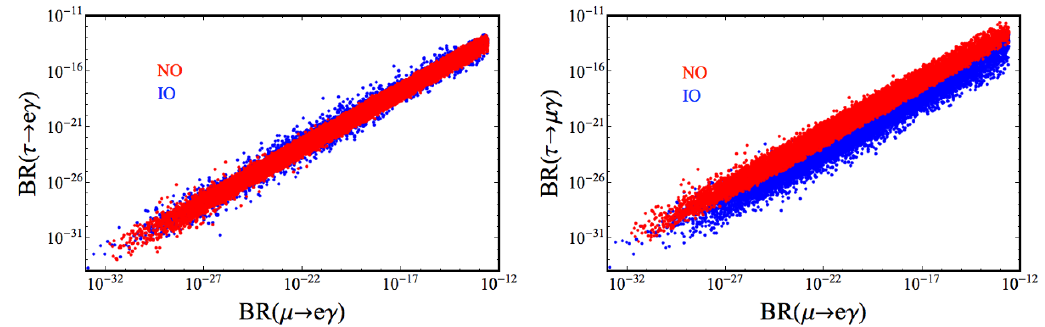
Figure 10 . Branching ratio of (cid:22) y (cid:8) versus for di(cid:11)erent ranges of (cid:21) H (cid:8)(cid:8) 0 . j j